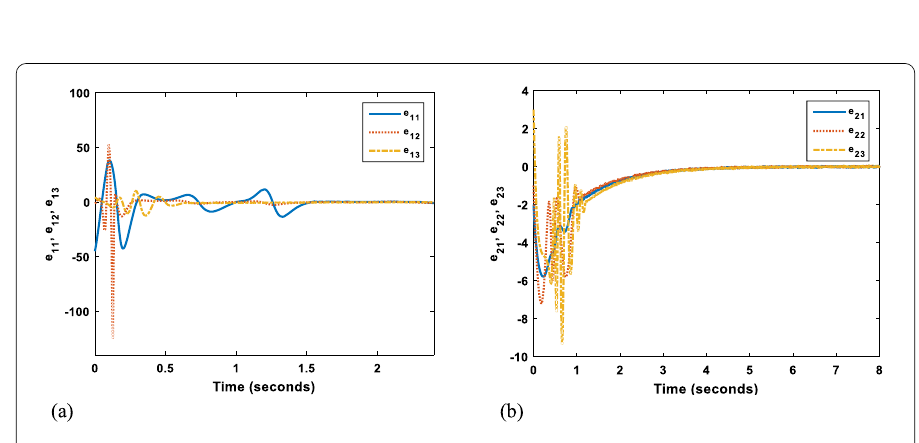
Figure 6 State trajectories of the error system: ( a ) e 11 ( t ), e 12 ( t ), e 13 ( t ) and ( b ) e 21 ( t ), e 22 ( t ), e 23 ( t )